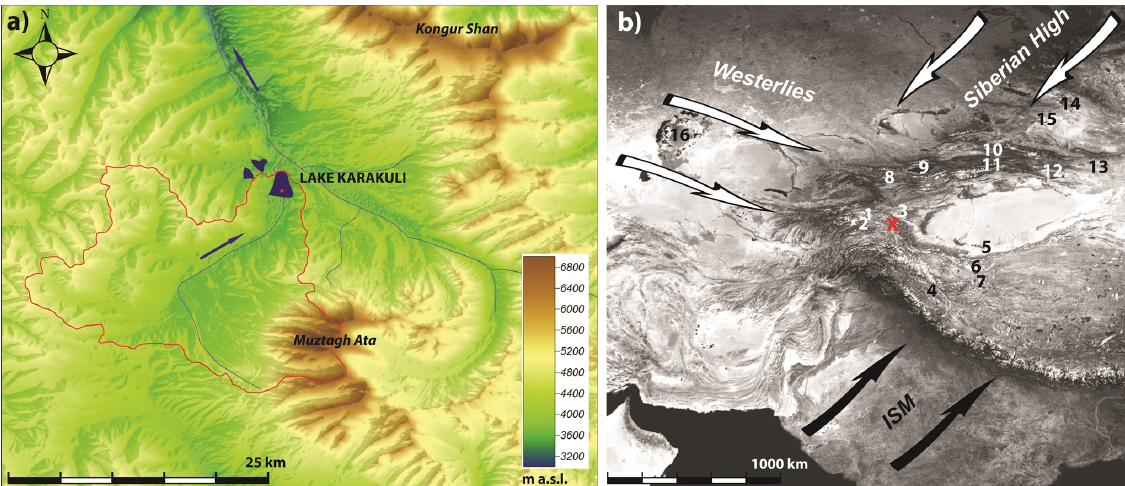
Figure 1. (a) Catchment of Lake Karakuli and coring position (red dot). (b) Location of our study area (red cross) and other